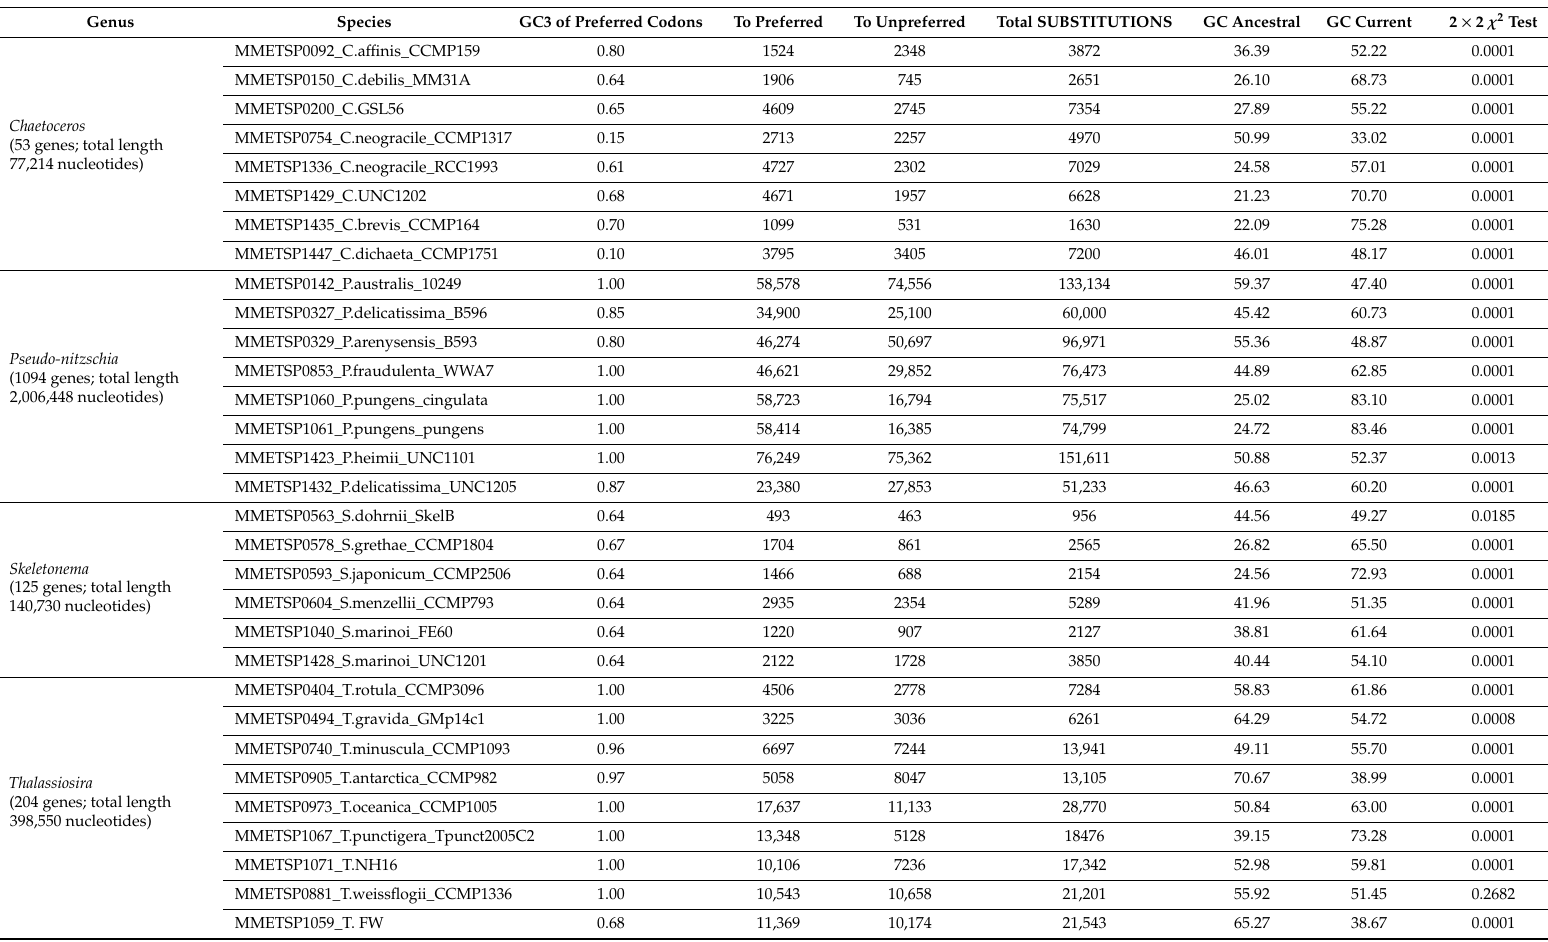
Table 2. Evolution of GC content at 3rd position of synonymous codons in the 4 diatom genera with > 7 strains